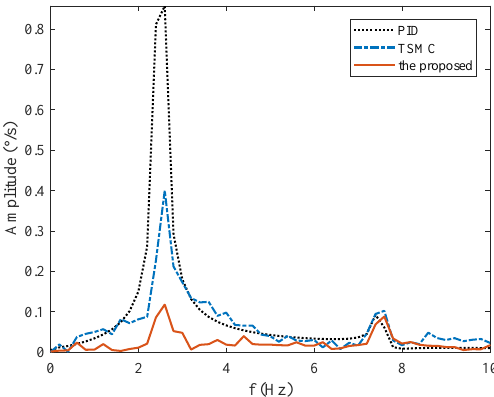
Figure 10. Frequency spectrum under Case III.